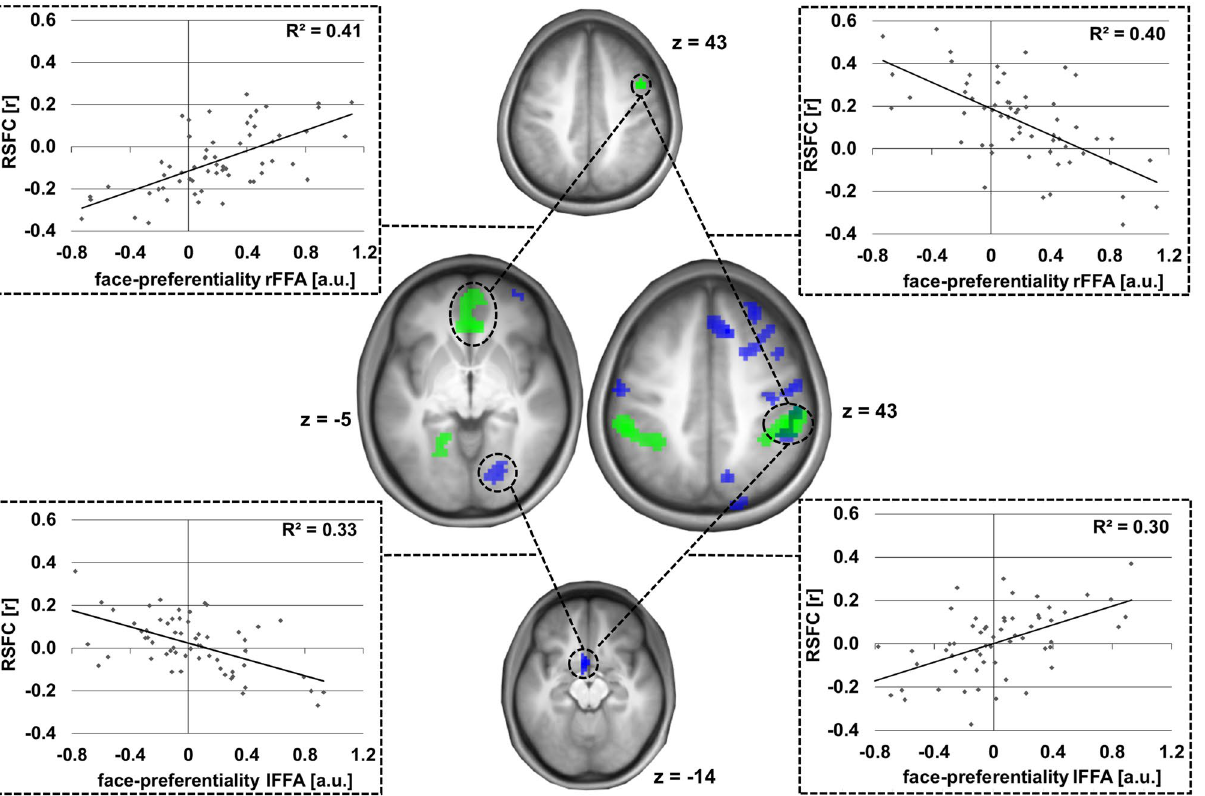
Figure 4. Divergence of informative RSFC patterns for bilateral FFA face-preferentiality. Individual face- preferential responses were assessed using minimum difference criteria (F > max[H, O, S]). Top and bottom middle: Two exemplary MVPA clusters informative of right (green) and left (blue) FFA face-preferentiality used as seed regions [see also Fig. 2b]. Centre middle: The seeds’ RSFC patterns associated with individual right (green) and left (blue) FFA face-preferentiality as evaluated post hoc. Results shown at a voxel-wise threshold of p < 0.001 and whole brain FWE-corrected at cluster level with a cluster threshold of p < 0.05. Coordinates refer to MNI space. The diagrams on the right and left sides illustrate the underlying association of face-preferential responses and